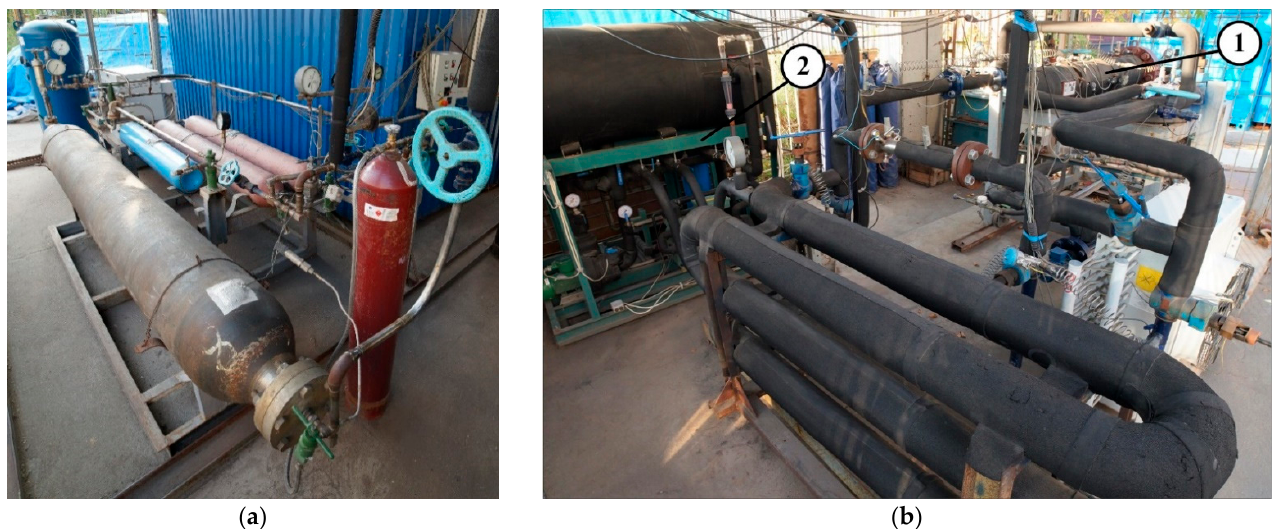
Figure 2. Experimental setup for study of natural gas charging and discharging processes from ANG storage system: ( a ) high pressure gas preparation unit and ( b ) circulating charging unit including adsorption tank (1) and coolant preparation unit (2).